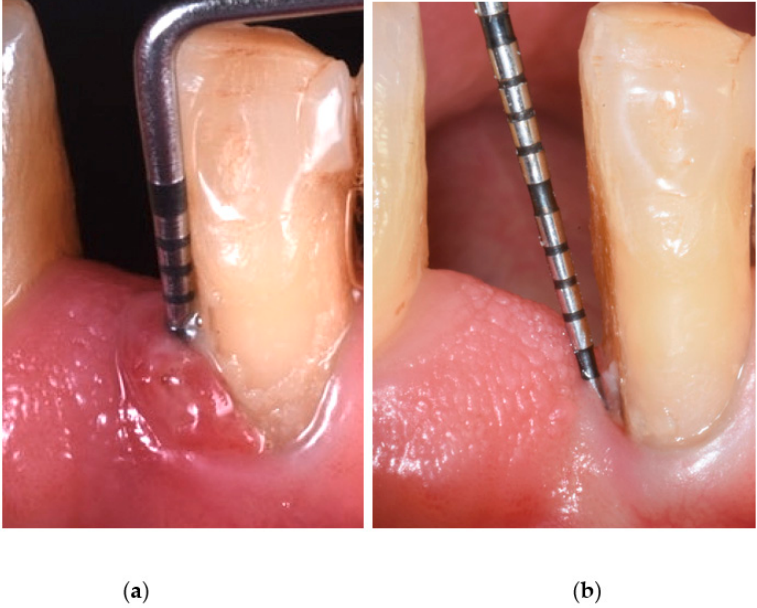
Figure 1. Probing pocket depth before ALAD-PDT treatment ( a ) and after ALAD-PDT treatment ( b ). Table 1. Clinical parameters were measured at baseline (T 0 ), after 3 months, and after 6 months in periodontitis sites treated with Aladent ®